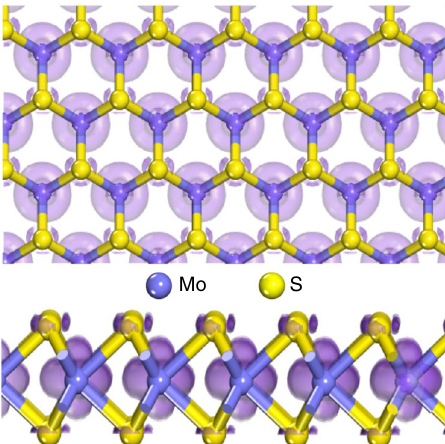
Fig. 1 The orbital analysis of the MoS 2 . The top-view (upper) and side-view (lower) orbital compositions of the conduction band in MoS